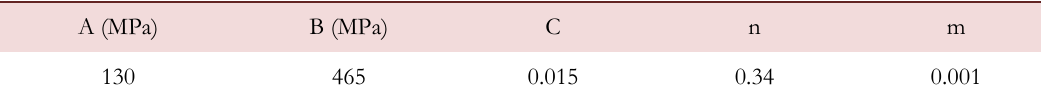
Table 6: Johnson’s Cook Failure Model Coefficients for Aluminum [33].